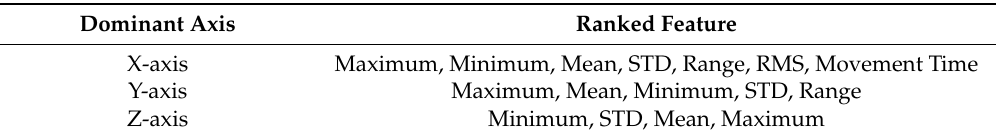
Table 6. Selected features of each dominant axis in ranked order for the significant change